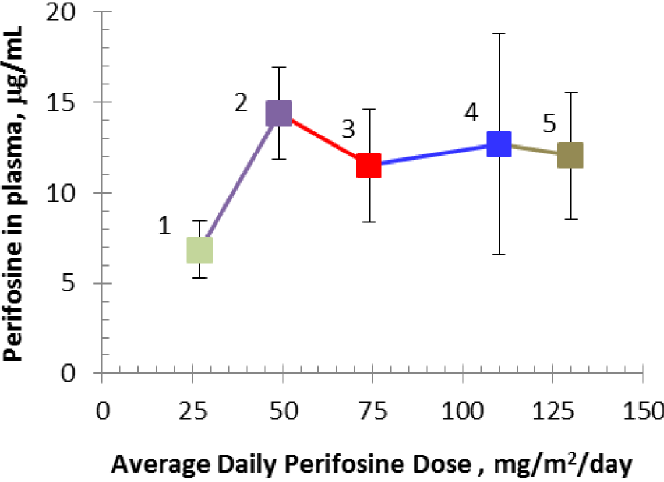
Fig 3. Correlation plot of perifosine steady state plasma concentration versus daily dose (actually administered). Error bars represent single standarddeviation;enumerated dose groups. Saturabledose exposureabove 50 mg/m 2 /day is observedin